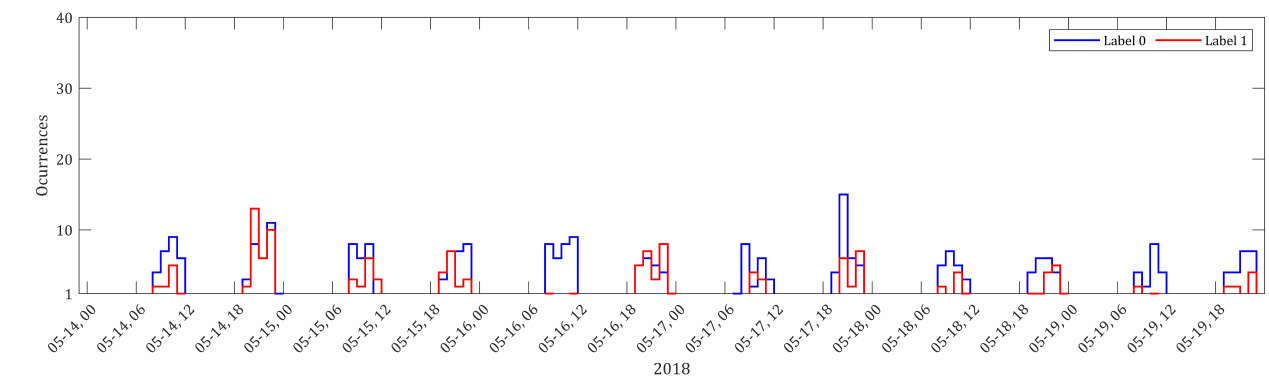
Figure 9. Local time distribution of labelled occultations between 14 May (DOY 134) and 19 May (DOY 139) in 2018. Label 0 observations are the majority of the observations in this period, alternating the trend observed in March 2015.